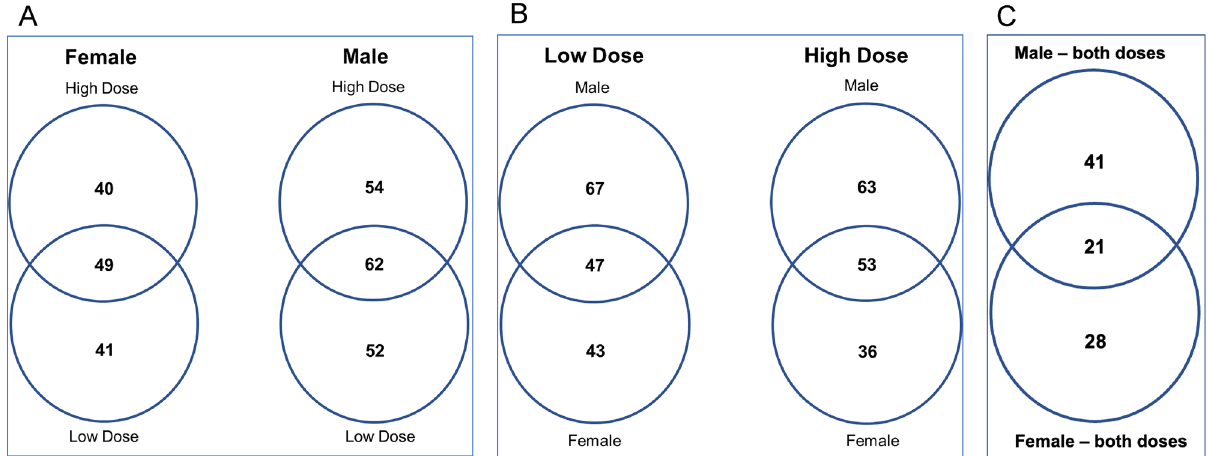
Figure 4. ( A ) miRNA radiation markers by dose. One-way ANOVA for each gender identified the number of significant (p ≤ 0.05) miRNAs for each condition, at any time point. ( B ) miRNA radiation markers by gender. One-way ANOVA for each gender identified the number of significant (p ≤ 0.05) miRNAs for each condition, at any time point. ( C ) The intersection of Figs. 4 and 5 by one-way ANOVA followed by Dunnett’s test (p ≤ 0.05). There are 21 miRNAs that are significantly regulated in both genders at either dose by